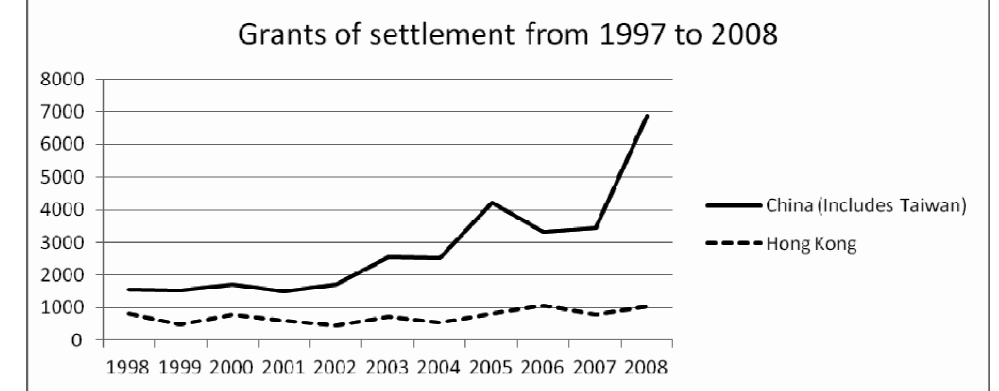
Figure 2: Grants of settlement from 1997 to 2008 Source: Data extracted from ‘Grants of settlement by country of nationality’, in Annual Abstract of Statistics, Office for National Statistics (various years, see Appendix 2) Chinese people from other parts of South East Asia, such as Taiwan, Malaysia, and Singapore, also migrated to Britain towards the end of the twentieth century (Benton and Gomez,